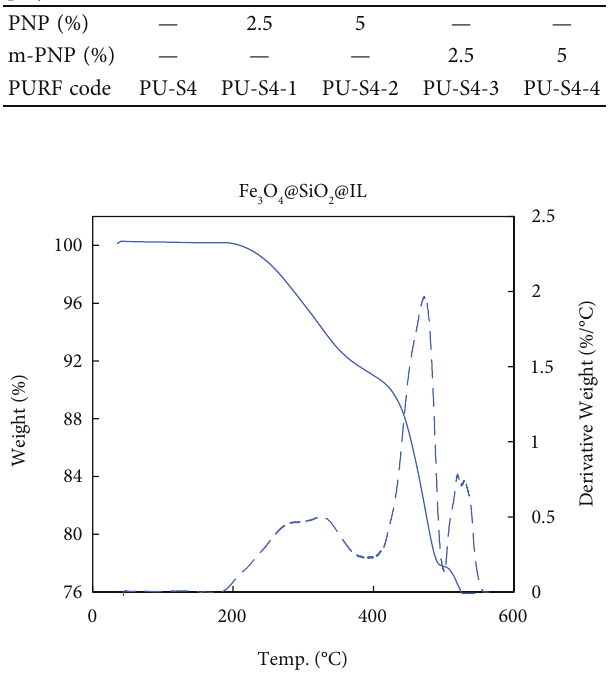
Figure 4: TGA-DTG of Fe